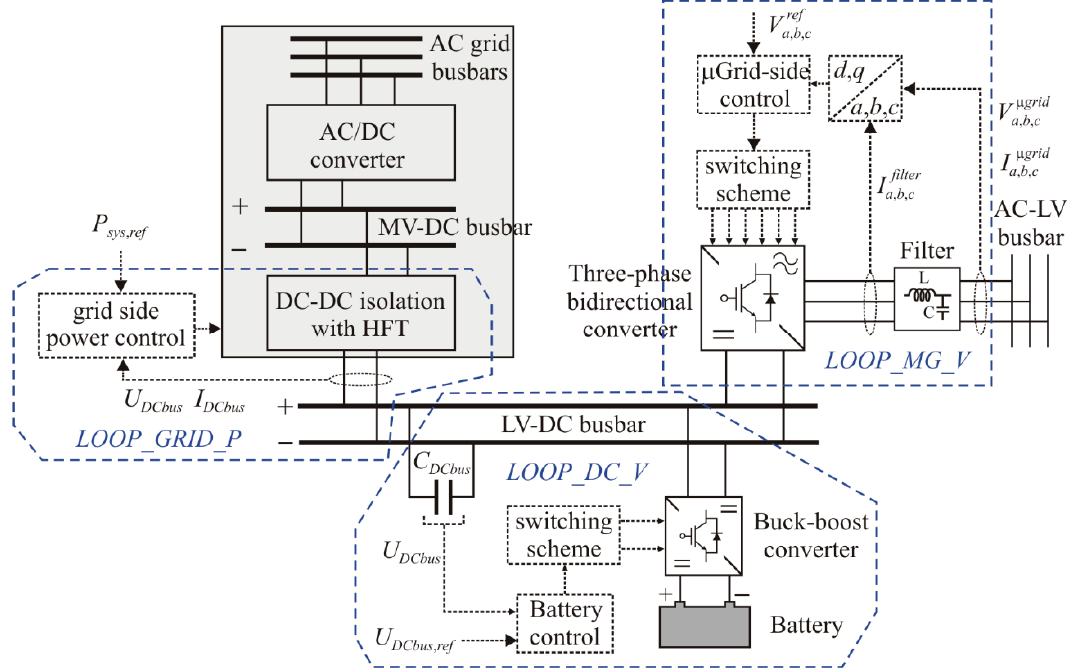
Figure 8. Simplified control scheme and the basic one-line diagram of the SST (straight line stands for the electric circuit, and the dashed line stands for the control loops).